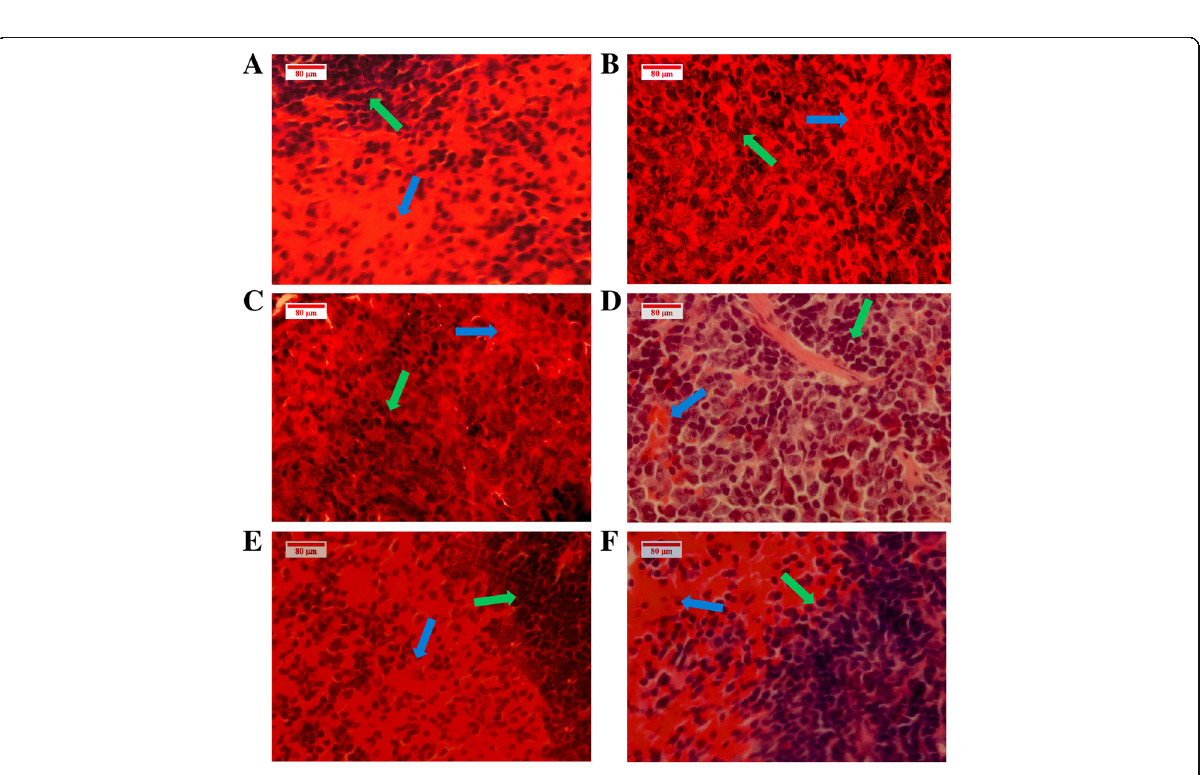
Fig. 12 Histopathology of the spleen tissues. The image shows ( a ) healthy BALB/c mice with normal white pulp ( green arrow ), red pulp ( blue arrow ) cells plainly visible, contrary to those of the leukaemic mice in whom the white pulp has expanded at the expense of the red pulp areas ( b , c ). The histology of the spleen in ( d ) and ( e ) of BM treated groups (30, 60 mg/kg) shows the regression of the white pulp and, at the same time, the red pulp has re-extended; this was also observed in the vinblastine group ( f